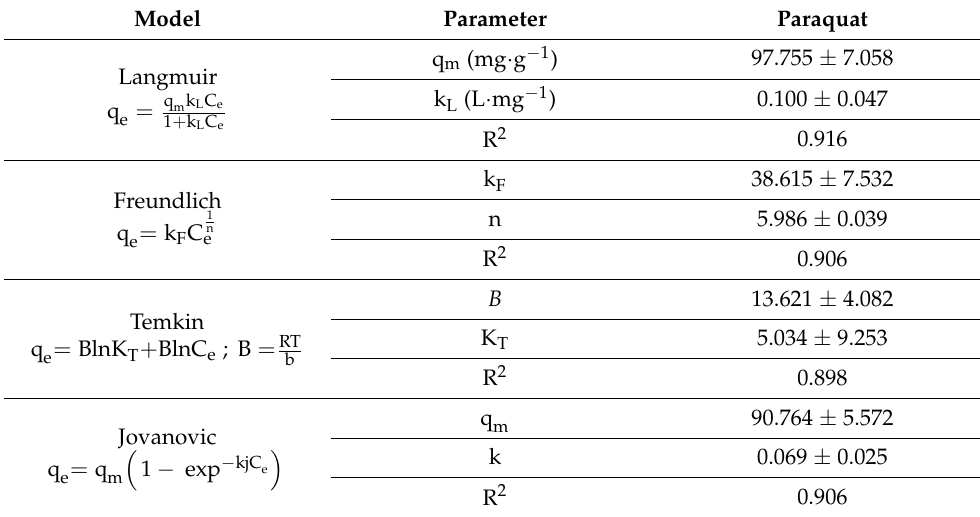
Figure 10. Adsorption curves for paraquat adsorption onto OPL − KOH − 800 − 1:4: ( a ) effect of initial concentration on the adsorption capacity; ( b ) adsorption isotherm curves. Table 6. Adsorption isotherm parameters of